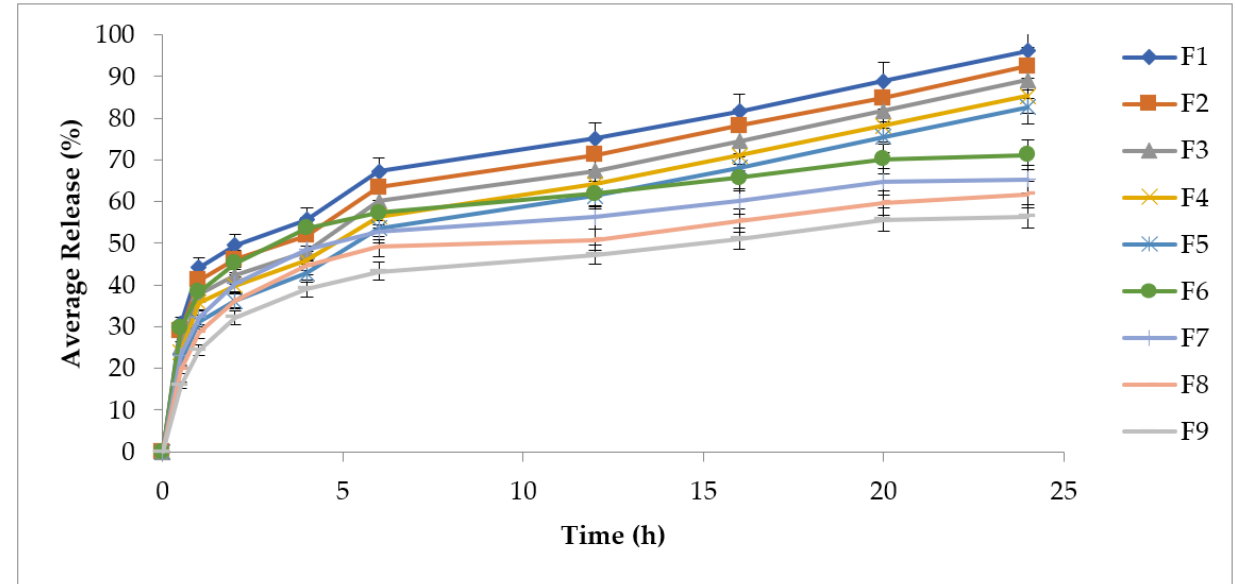
Figure 3. Release profile of MTX from F1 to F9, data were expressed as mean ± SD, n = 3.